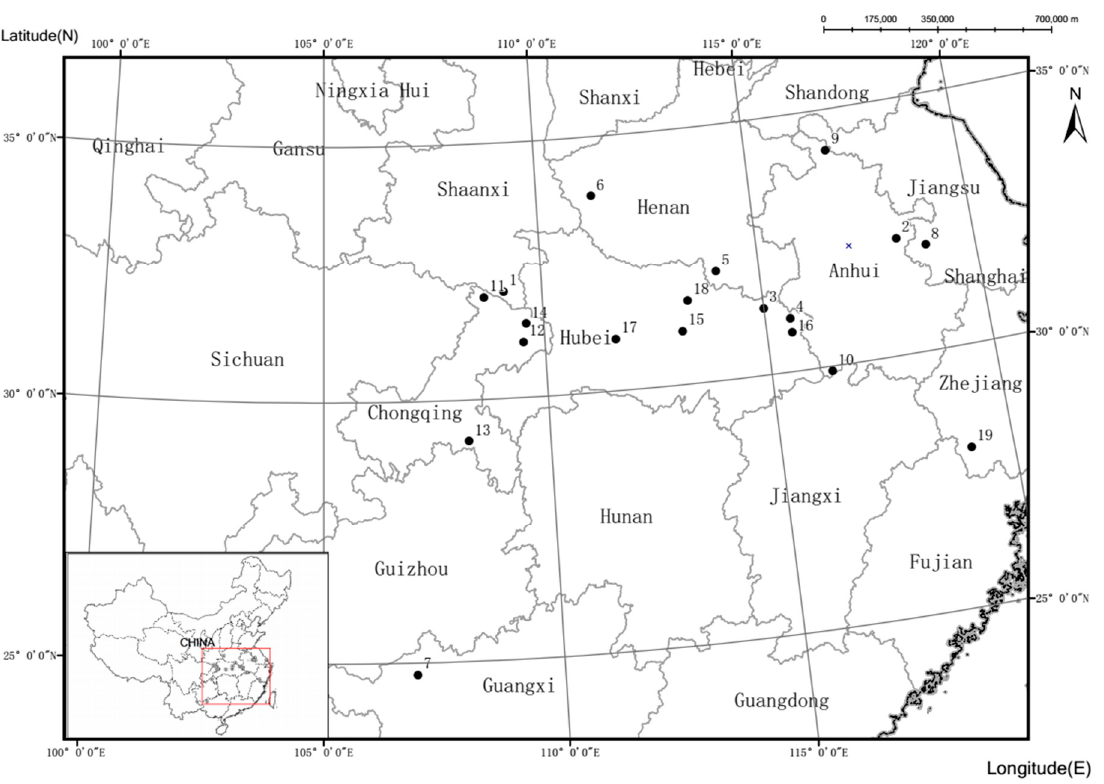
Figure 1. Locations of the 19 investigated populations of Q. variabilis . Numbers correspond to the population numbers in Table 1.